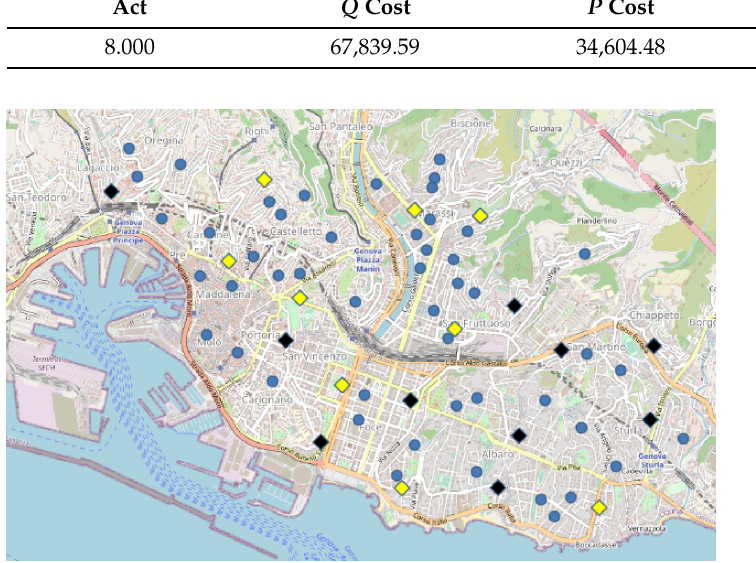
Figure 6. Activated pickup-delivery stations in the optimal